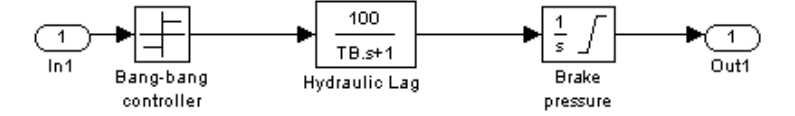
Figure 16. Simplified solenoid valve brake actuator.